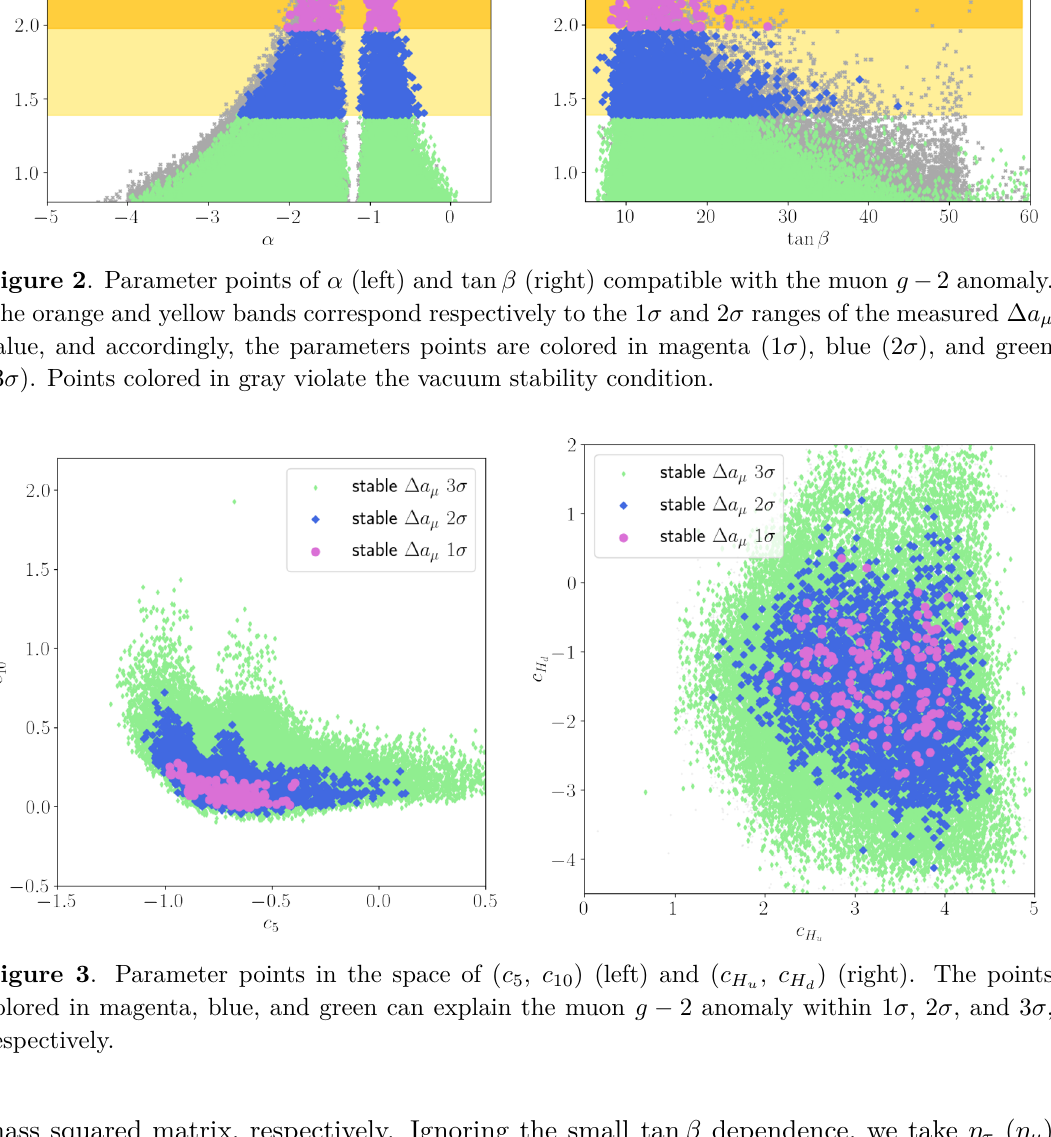
, c H ) (right). The points u d